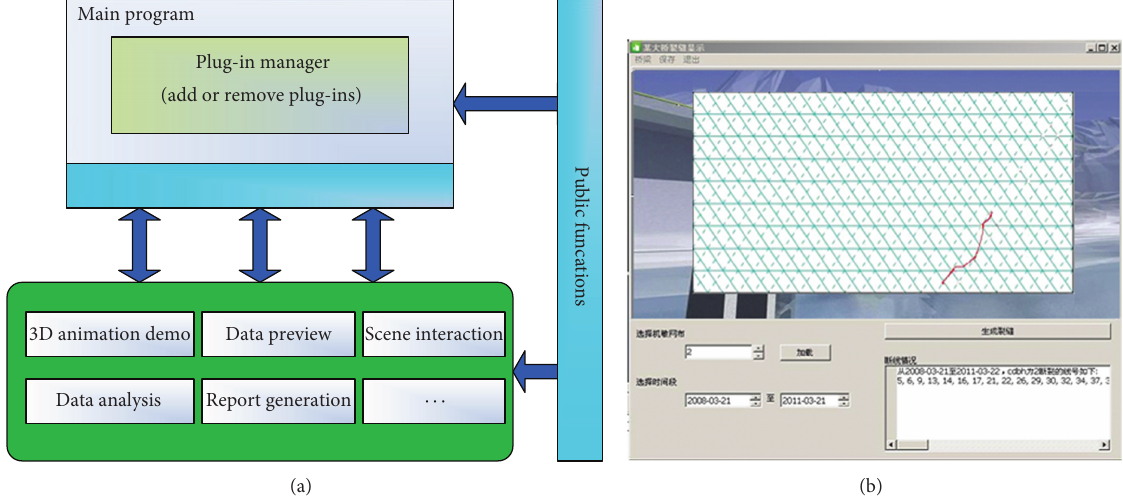
Figure 10: 3D visualization system: (a) system framework and (b) the plug-ins of analysis and recurrence of crack data.